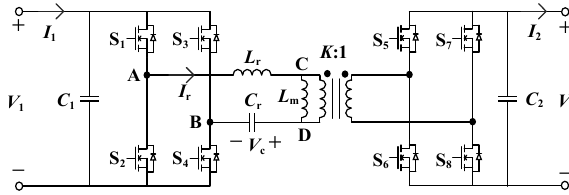
Figure 1. Topology of an LLC resonant